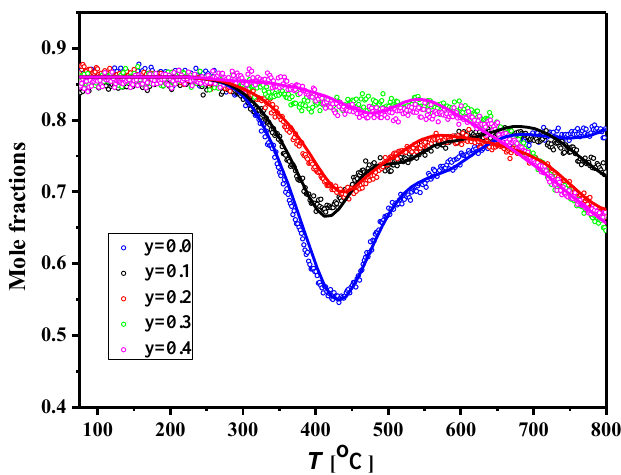
Figure 7. Temperature-programmed isotope exchange of oxygen with C 18 O 2 in the flow reactor for the NCNCO samples with different copper content. Points — experiments, lines — modeling. Table 6. Oxygen tracer diffusion coefficients ( D * ) at 700 °C and their effective activation energies